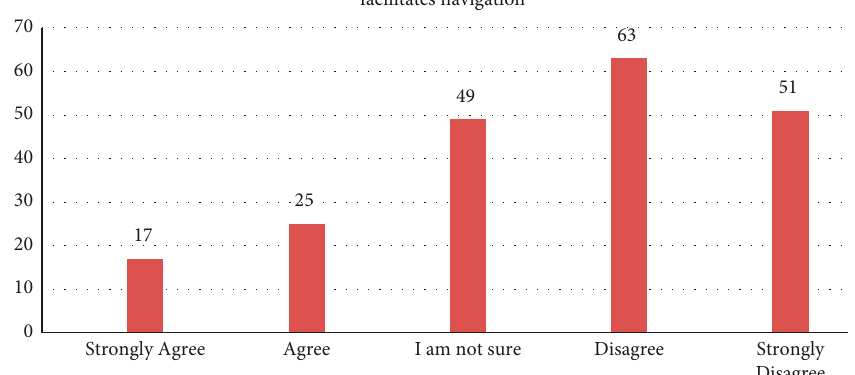
Figure 4: Participants’ responses of the to the easy navigation of Amazon.